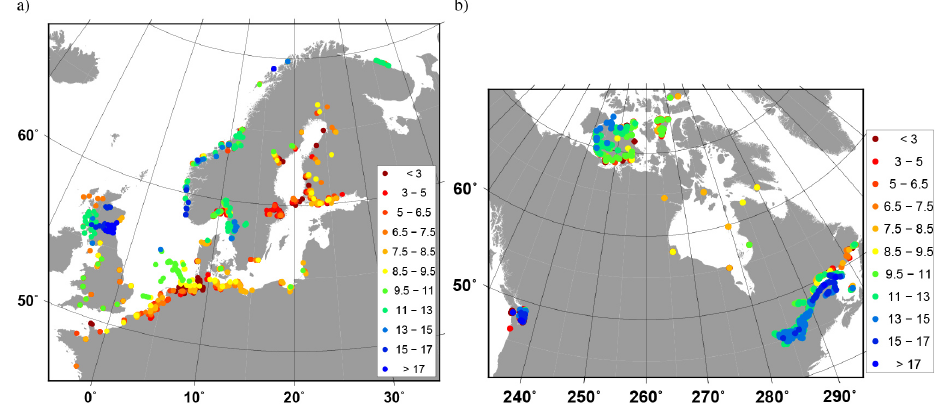
Figure 1. Exemplary overview of the location of relative sea-level data in (a) northern and central Europe and (b) North America. Colored dots highlight their age. Unit in ka (calendar years before